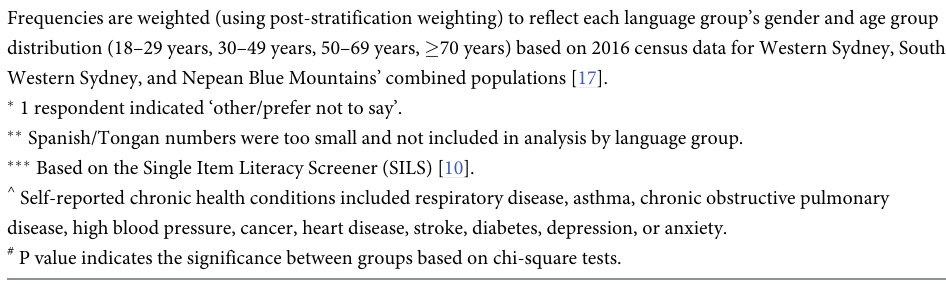
Table 1. Reporting of positive impacts ranged from 12% (n = 9) for people aged seventy years or older to 30% (n = 90) for the 30–49-year age group. There were significant differences across language groups (p < 0.001), the range was between 9% (n = 11) for Croatian speakers, to 42% (n = 18) for Hindi speakers. There were significant differences across genders; 18% (n = 61) of men reported positive impacts compared to 27.5% (n = 100) of women (p = 0.004), and 18% (n = 51) of people with inadequate health literacy reported positive impacts compared to 26% (n = 110) with adequate health literacy (p = 0.014). There was no significant difference among participants who did or did not report chronic health conditions when finding posi- tives; 25% (n = 106) of people with no self-reported chronic health conditions reported posi- tives compared to 20% (n = 31) with one and 18% (n = 24) with two or more self-reported chronic health conditions (p = 0.280). There was no significant difference between 23% (n = 52) of participants in the lowest IRSAD quintile reported positives compared to 23% (n = 109) not in the lowest. The proportion of people reporting positives was significantly higher for people with children less than 18 years (31%, n = 82) compared to those without (11%, n = 79; p = 0.001). There was no significant difference for those who reported positives between those who had experienced a change in employment status and those who had not (p =